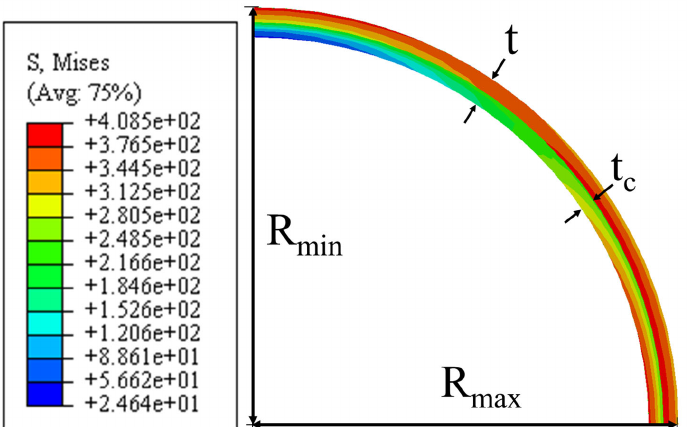
Figure 17. Schematic diagram of ovality. Where t is the thickness of the pipe without defect, and t c is the pipe wall thickness at the local defect location. CFRP significantly enhances the external pressure resistance of the pipeline and re ‐ duces the ovality when the pipeline is crushed. As shown in Figure 18, the maximum stress and ovality of the steel pipe before and after repair both increase with the increase in external pressure. Before the repair, when the external pressure reached 7.84 MPa, the ovality in the middle of the pipeline defect was 4.08%, and the maximum stress of the repaired pipeline reached 404.67 MPa, which was higher than the maximum stress of 385.18 MPa before the repair. Therefore, when the external pressure reached 10.15 MPa, the local stress of the repaired pipeline exceeded the yield strength of the steel pipe mate ‐ rial. However, there is no large ‐ scale collapse due to the limitation in CFRP. According to previous studies, the collapse pressure of the pipeline is positively correlated with the ovality. Therefore, CFRP increases the radial stiffness of the pipeline and the stability of the defect parts, limits the deformation of the steel pipe, and improves the overall stability of the pipeline.